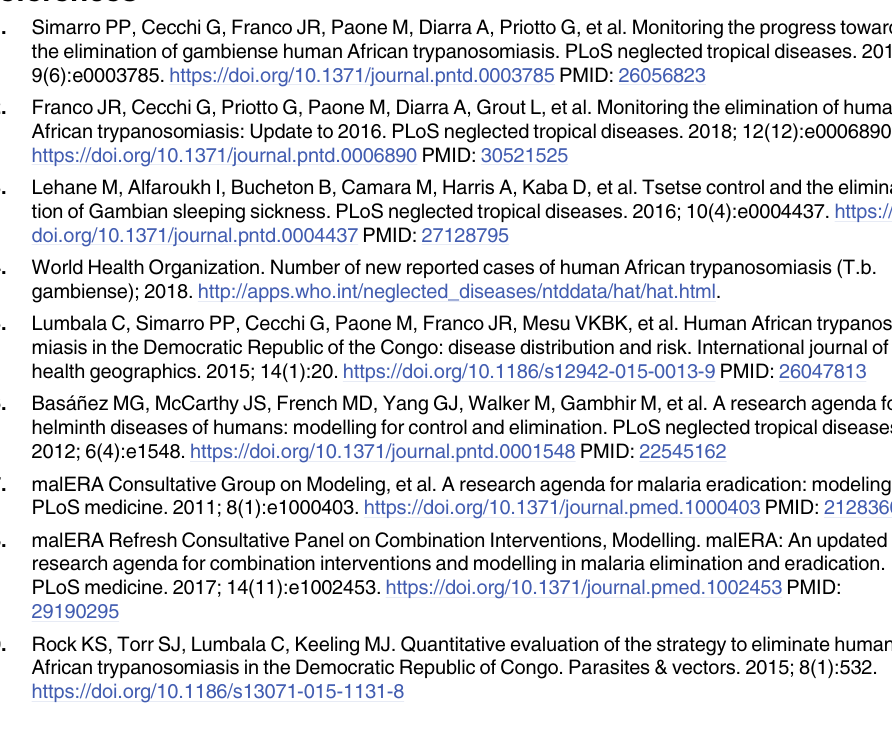
different fitting. The posterior median is shown as a point. Dashed lines indicate projections based on fit to subset staged